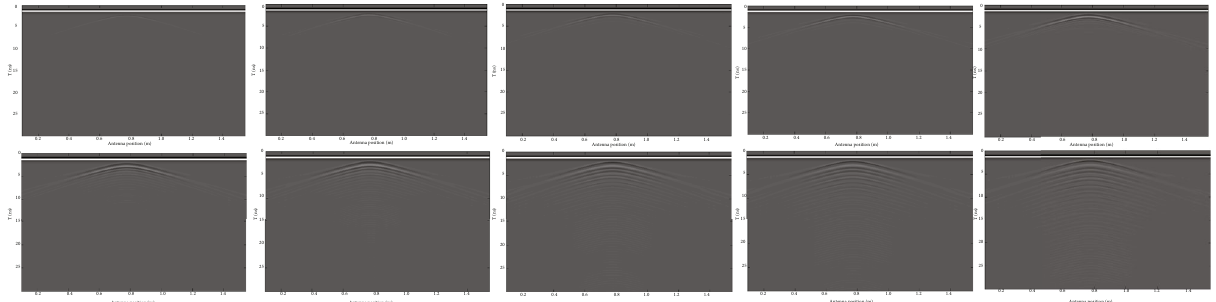
Figure 12: Gray diagram of numerical simulation of a tubular object with change of dielectric constant.